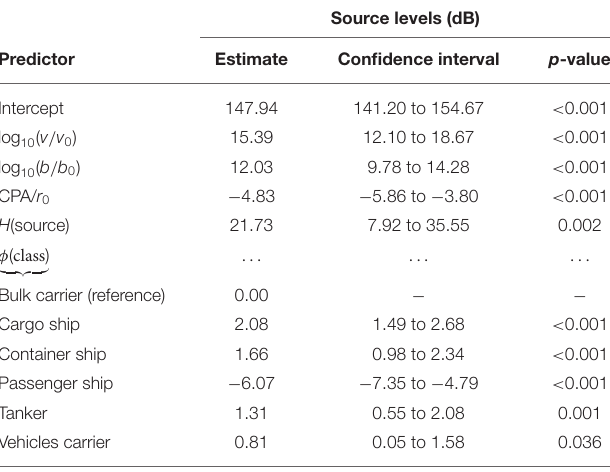
TABLE 3 | Generalized Linear Mixed Model applied to our